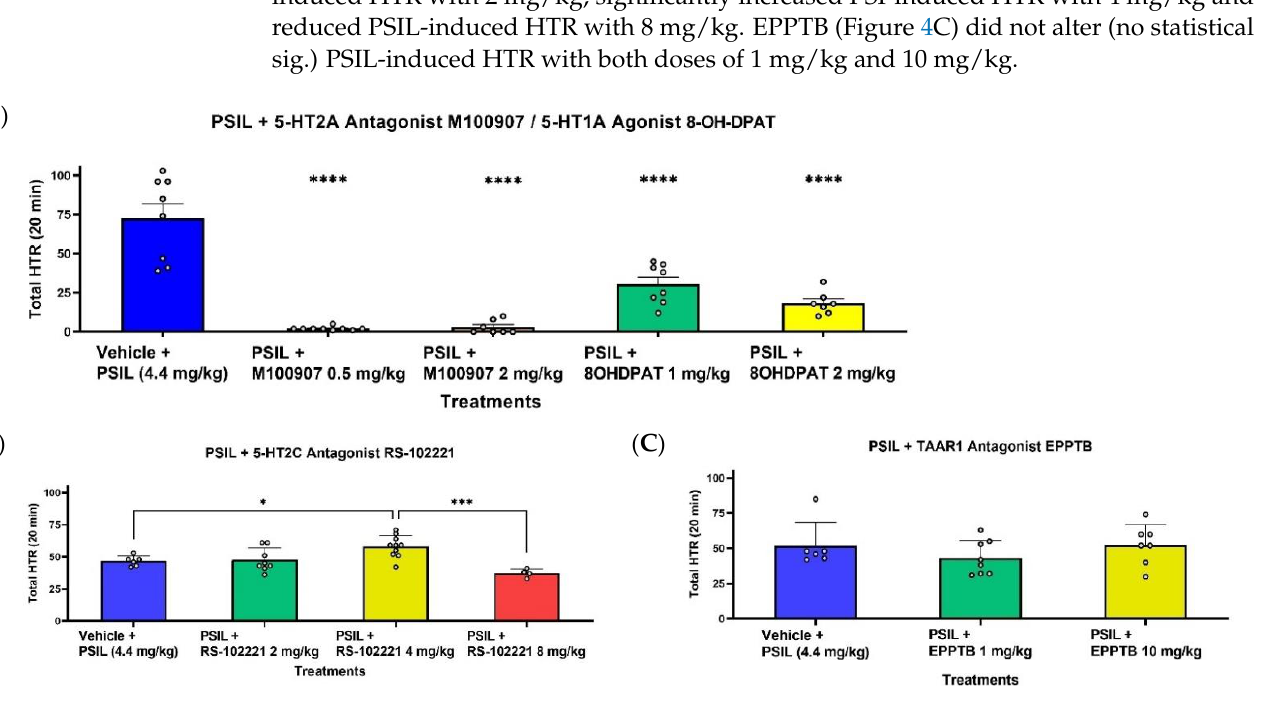
Figure 4. Total PSIL-induced HTR ( A – C ) during 20 min post injection with different co-treatments. ( A ) Effect of pre-treatment with M100907 0.5/2 mg/kg + PSIL 4.4 mg/kg, 8-OH-DPAT 1/2 mg/kg + PSIL 4.4 mg/kg or vehicle + PSIL 4.4 mg/kg ( n = 7 − 8) ( B ) Effect of pre-treatment with RS − 102221 2/4 8 mg/kg + PSIL 4.4 mg/kg or vehicle + PSIL 4.4 mg/kg ( n = 4 − 11). ( C ) Effect of pre-treatment with EPPTB 1/10 mg/kg + PSIL 4.4 mg/kg or vehicle + PSIL 4.4 mg/kg ( n = 6 − 8). Compared to vehicle ( A , C ) and between treatments ( B ), * p < 0.05, *** p < 0.001, **** p < 0.0001. Error bars represent SEM . To assess any difference between the 5-HTP and PSIL induction profiles of HTR, we chose doses with comparable maximal HTR. 5-HTP 200 mg/kg was compared to PSIL 3 mg/kg (Figure 5). A somewha t “mirror image” HTR profile was obtained. Although both doses of compounds reached the same peak HTR, the way the HTR was induced was